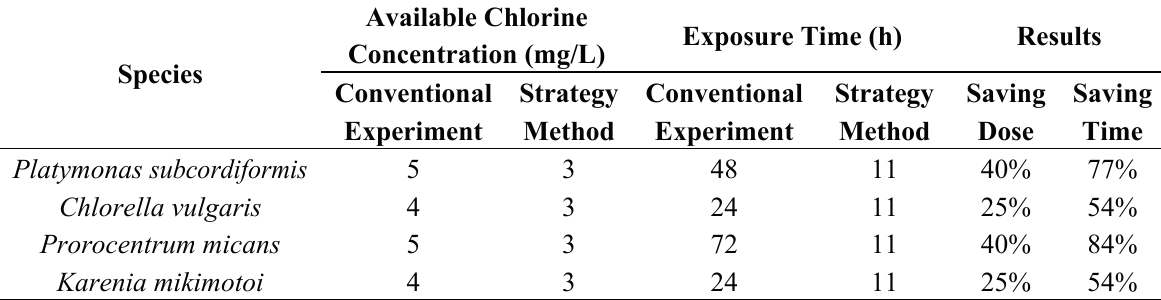
Figure 3. ( a ) The MRs of Platymonas subcordiformis by multi-trial injection with a small dose of electrolytic products; ( b ) The MRs of Chlorella vulgaris by multi-trial injection with small dose of electrolytic products; ( c ) The MRs of Prorocentrum micans by multi-trial injection with small dose of electrolytic products; ( d ) The MRs of Karenia mikimotoi by multi-trial injection with small dose of electrolytic products. Table 1. Comparison between the treatment strategy of Group B and conventional one trial injection treatment